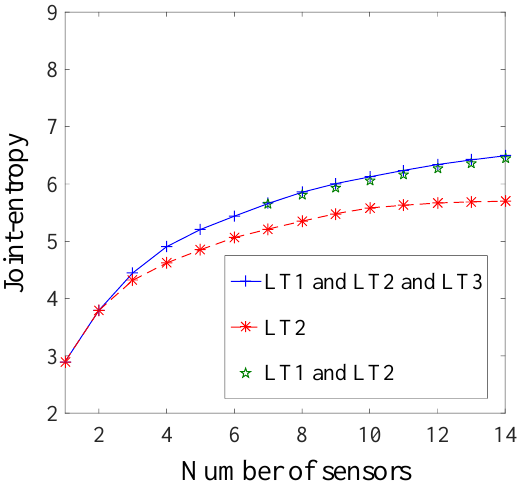
Figure 11. Sensor ranking for the original hierarchical algorithm using three load tests without considering their mutual information.